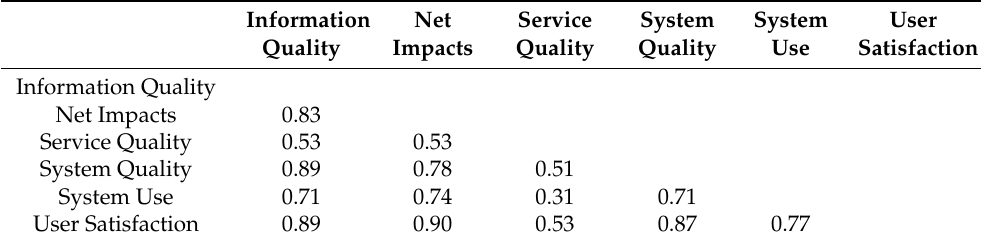
Table 3. Heterotrait–monotrait (HTMT).